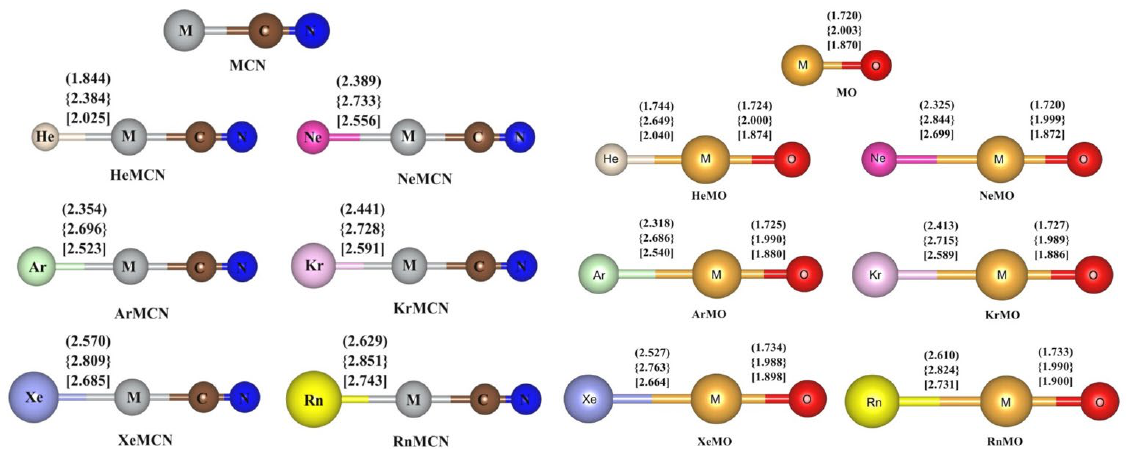
Figure 1. Optimized geometries of the Ng-bound noble metal cyanides (at CCSD(T)/def2-TZVPPD level) and oxides (at CCSD(T)/ccpVTZ/cc-pwCVTZ-PP level) along with the bond distances (in Å) for the Cu, Ag, and Au analogues within parentheses, square bracket, and braces, respectively. [Adapted from Refs. [75,76] with permission from John Wiley and Sons. © 2015 and © 2016 Wiley Periodicals, Inc., respectively] .